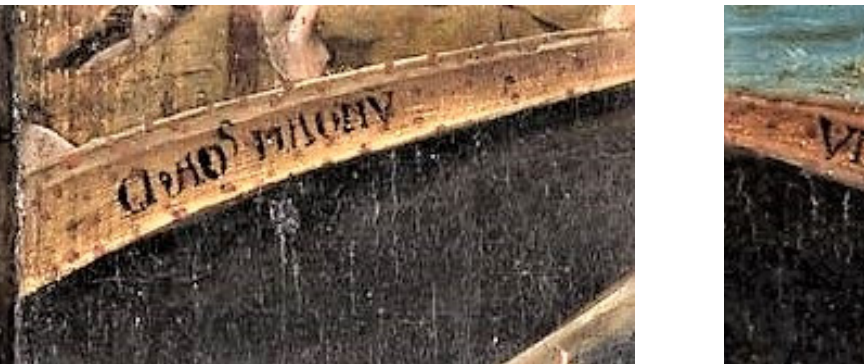
Figure 8. Detail of Figure